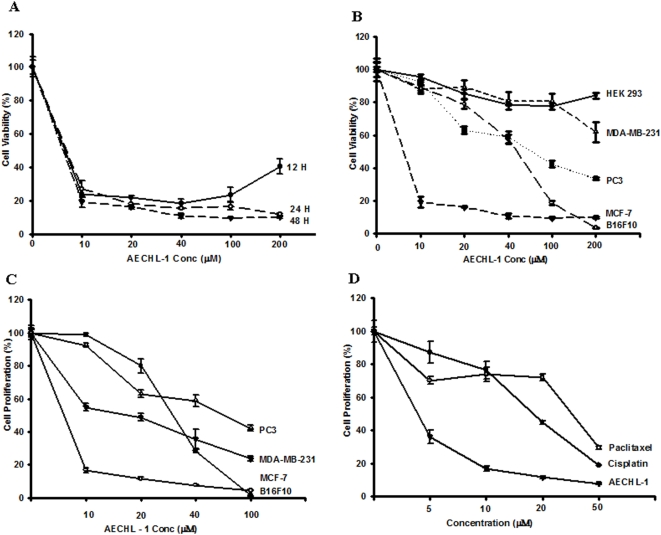
Growth inhibition and cell proliferation of different tumor cell
lines by AECHL-1 in vitro.(A) Cell growth by MTT assay in MCF-7 cells were treated with different
concentrations of AECHL-1 (10, 20, 40 and 100 µM) for 12, 24
and 48 hr and cell viability was determined by MTT assay; (B) Cell
growth by MTT assay in B16F10, PC3, MDA-MB-231 MCF-7 and HEK-293 cells.
Cells were treated with different concentrations of AECHL-1 (10, 20, 40
100 and 200 µM) for 48 hr, and cell viability was determined
by MTT assay; (C) Cell proliferation by (3H) thymidine
incorporation in B16F10, PC3, MDA-MB-231, and MCF-7 cells. Cells were
treated with different concentrations of AECHL-1 (10, 20, 40 and 100
µM) for 48 hr, and cell proliferation was determined by
(3H) thymidine incorporation; (D) Comparison of AECHL-1
with other chemotherapeutic drugs. MCF-7 cells were treated with
different concentrations (5, 10, 20, and 50 µM) of paclitaxel,
cisplatin and AECHL-1 for 48 hr, and cell proliferation was determined
by (3H) thymidine incorporation. Data are
means±SEM of three independent experiments.